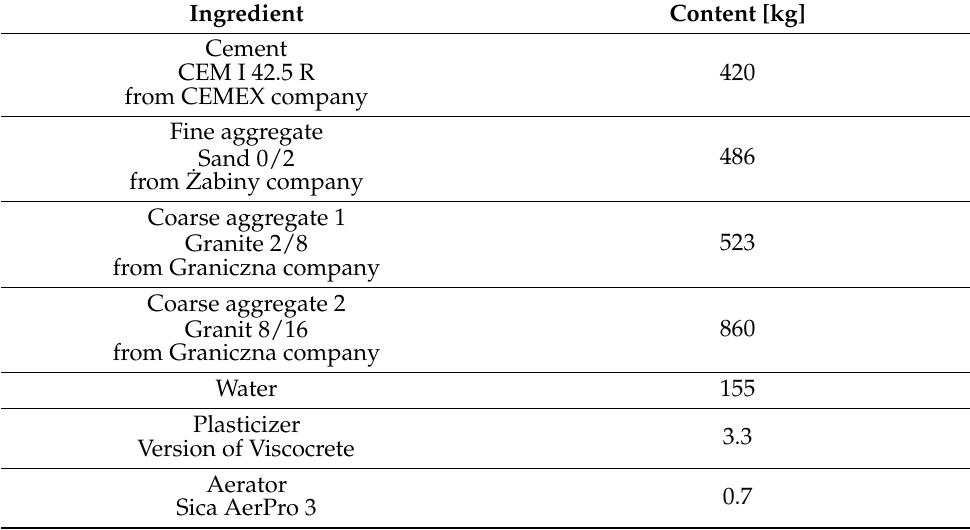
Table 4. Design of concrete mix for block